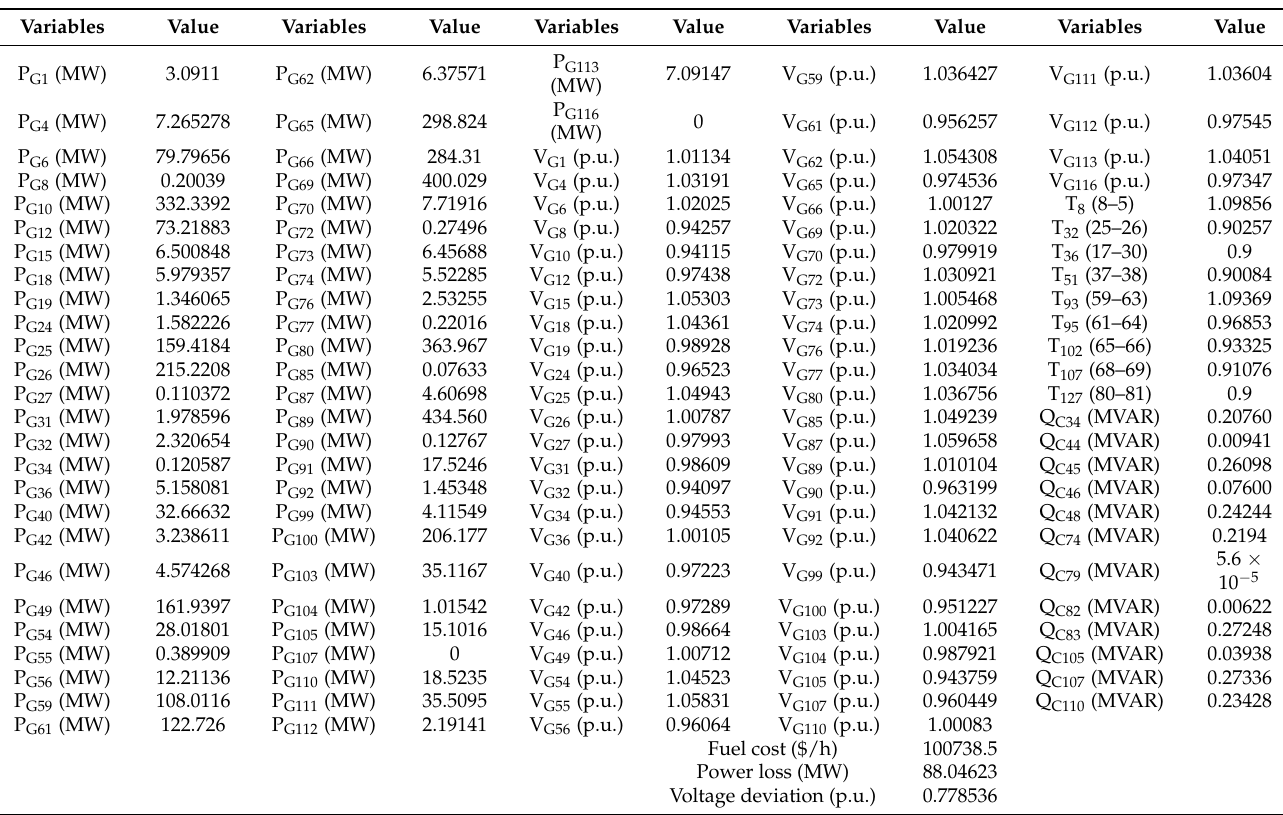
Table 11. Optimal settings of control variables for case 5 using the proposed MRao-2.